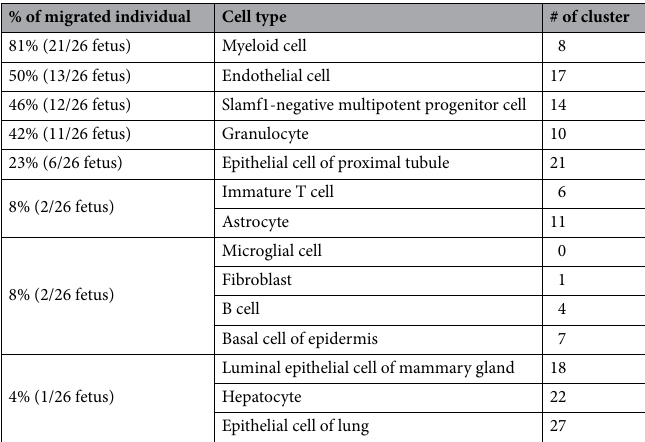
Table 1. MMc cell types detected in the analyzed embryos in the current